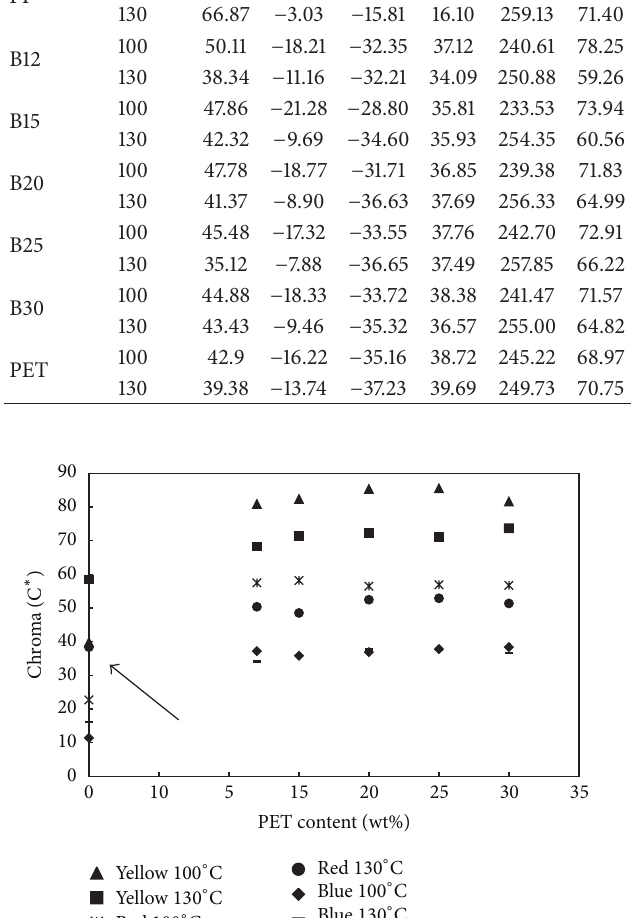
Table 5: Colorimetric attributes of dyed samples under D65 standard illuminant and 10 ∘ standard observer. Blue disperse dye Yellow disperse dye Red disperse dye Sample Temp. ( ∘ C)